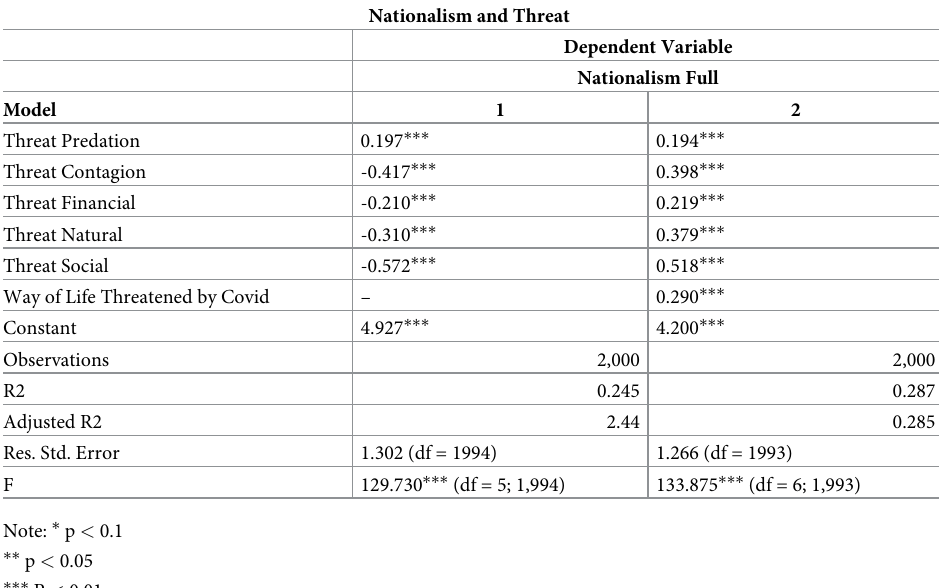
Table 2. Regressions predicting nationalism levels from threats.